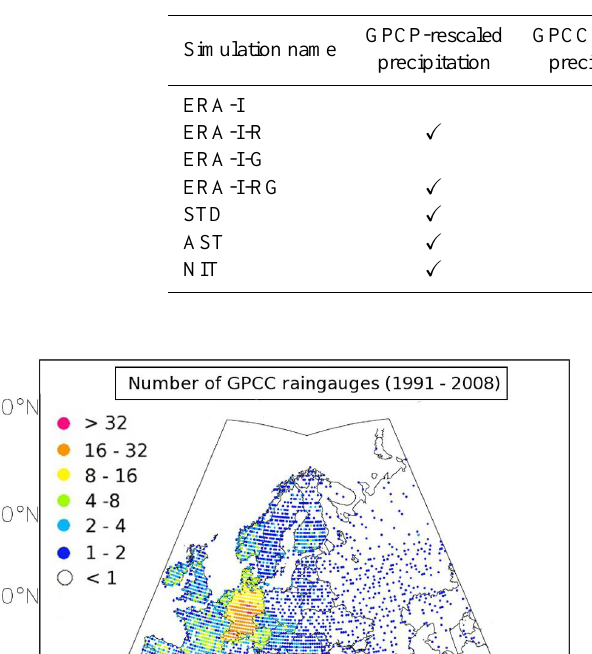
Table 1. Description and references of the different configurations of the ISBA-TRIP river discharge simulations. It can be noted that ERA- I-RG and NIT represent the same experiment.